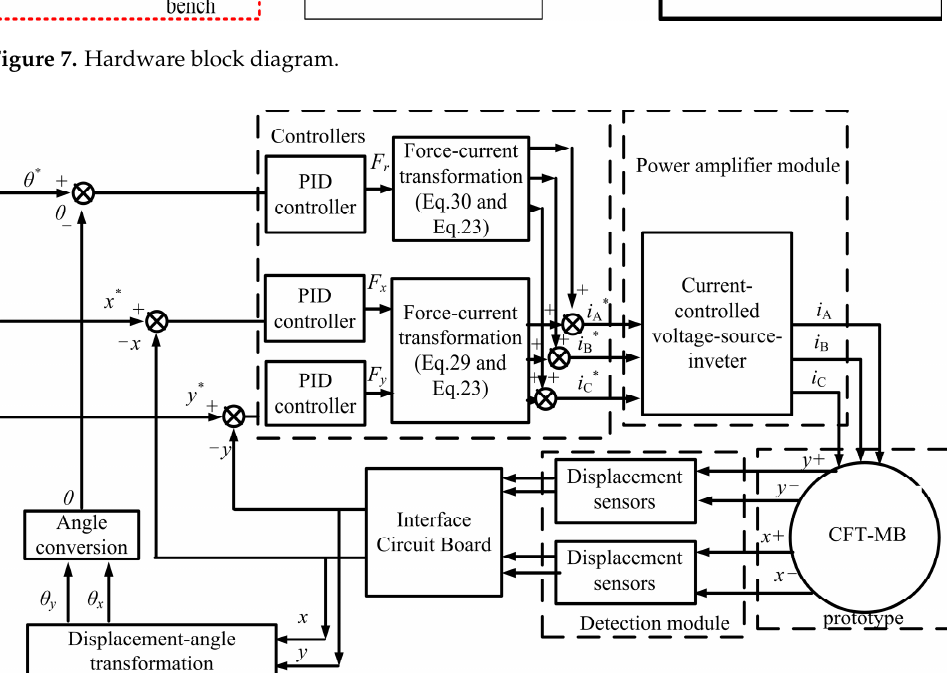
Figure 8. Suspension control diagram. Table 1. Prototype parameter